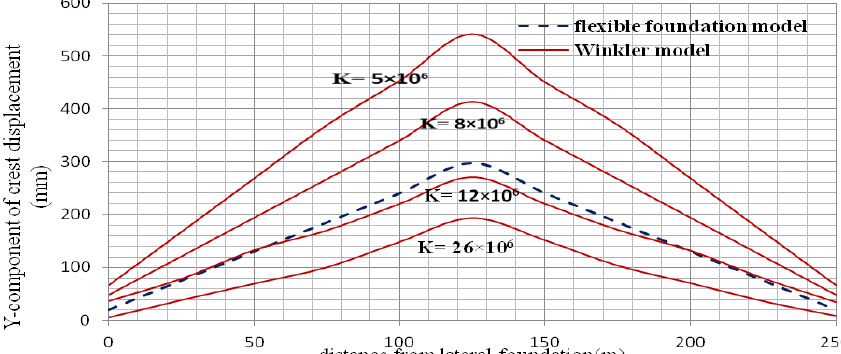
Fig. 7. The dam crest displacement for different modes of the subgrade reaction coefficient in the Winkler